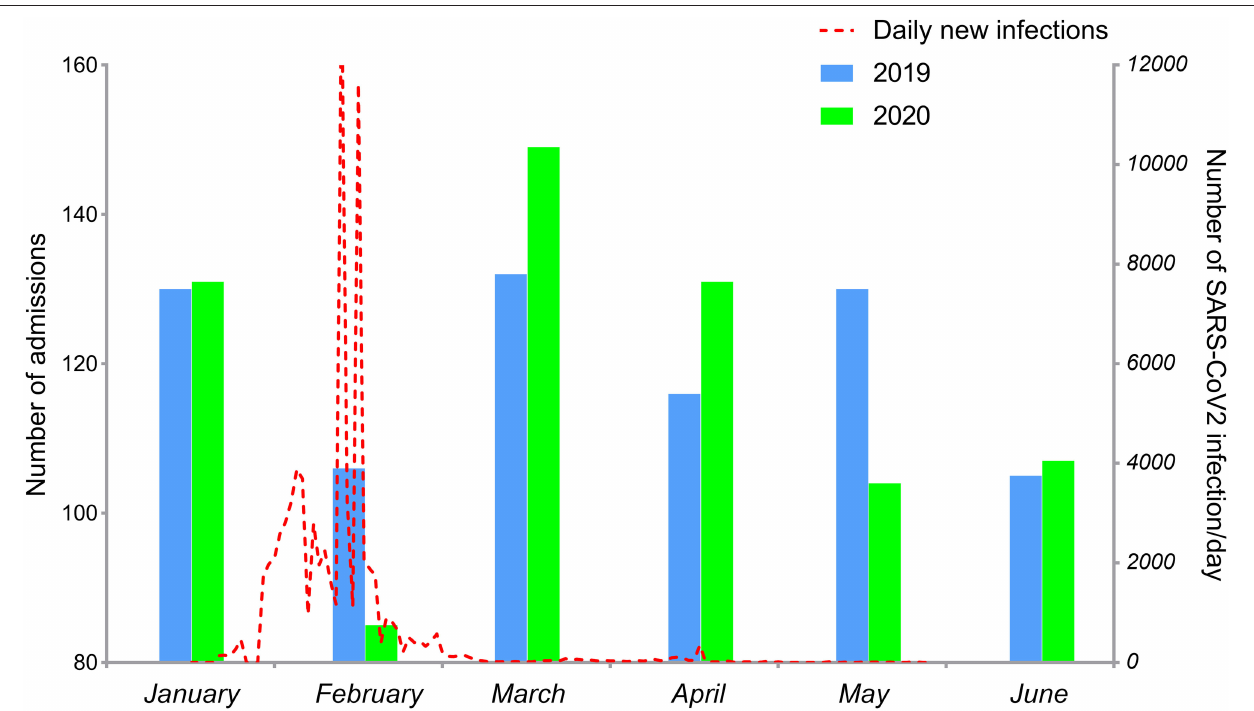
FIGURE 1 | Monthly admission rates for ICH between January and June 2019 (blue column) and January and June 2020 (green column). Daily new COVID-19 cases in China between January 20 and June 30, 2020, (red dotted line).